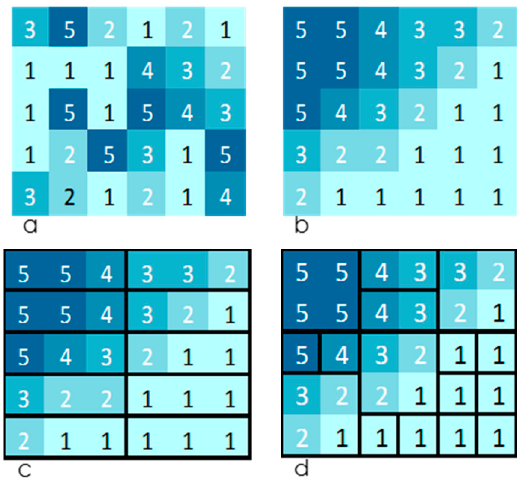
Figure 5. Four interpretations of the same distribution of 30 squares colored with five different tones of blue. Numbers indicate each tone used. The lightest is represented by 1 and the darkest with 5. Each tone appears with the same frequencies in the four graphs. ( a ) Shows the 30 squared randomly ordered; ( b ) The squares are ordered according to the rule indicating that no darker square can appear below or at the right of another lighter square; ( c ) Shows groups of symbols formed by a regular shaped lattice of 1 × 6 bricks; ( d ) Shows with black borders the groups of squares forming symbols to reduce the entropy of this interpretation.